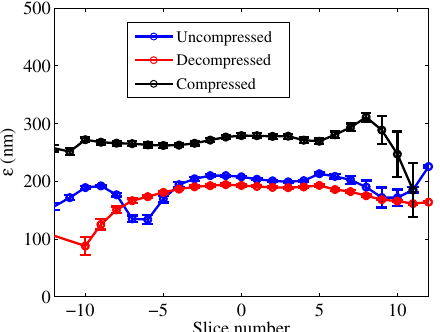
FIG. 9. Measured horizontal slice emittance for the uncom- pressed, compressed and decompressed beam. (For this meas- urement the bunch charge was limited to 70 pC because of a temporary depletion of the photocathode quantum